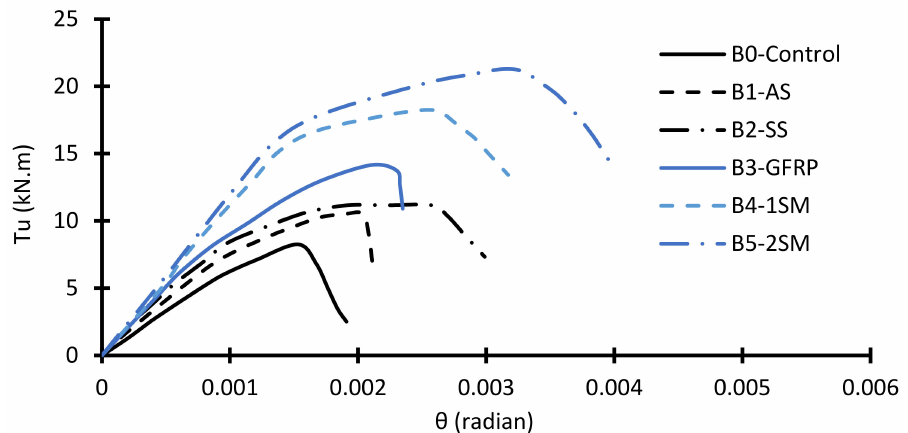
Figure 21. Torque–twist curve of tested beams.